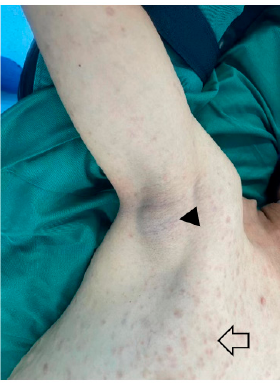
Figure 1. A 41-year-old male with Cafe-au-lait macules of NF1-associated with MPNST. The macules spread throughout the body ( 🢠 ), and MPNST is under the skin of the right axilla ( ▲ ).